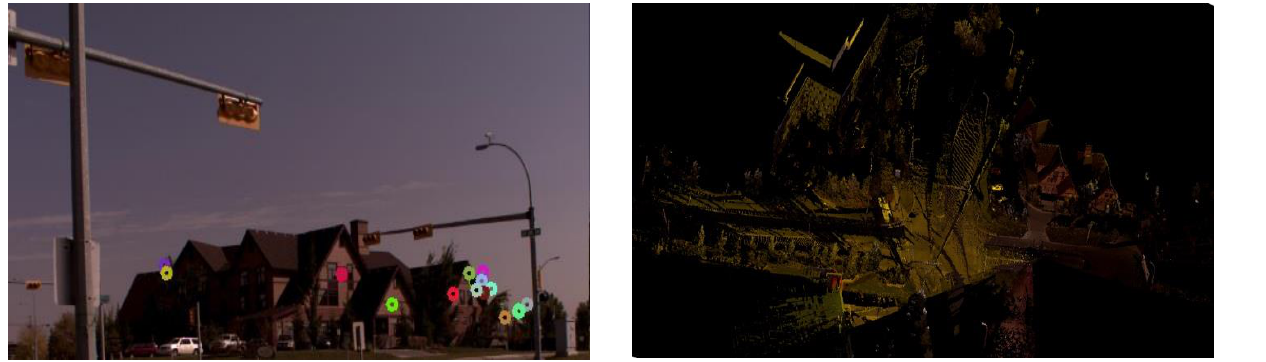
Figure 1.Image taken by the ILRIS Camera associated with reference Scan